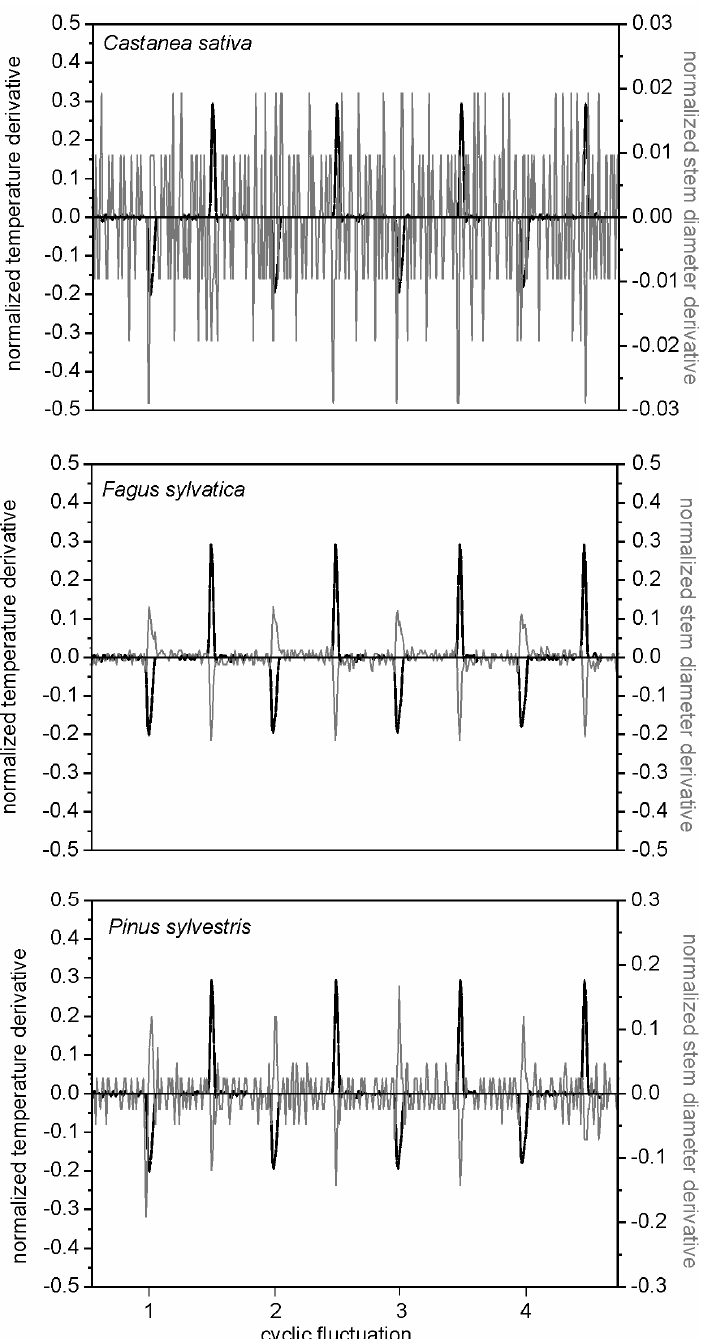
Figure 5. Normalized derivative of temperature (black line) and stem diameter (grey line) of C. sativa , F. sylvatica and P. sylvestris logs exposed to cooling test, showing detail of four repeated cooling cycles.